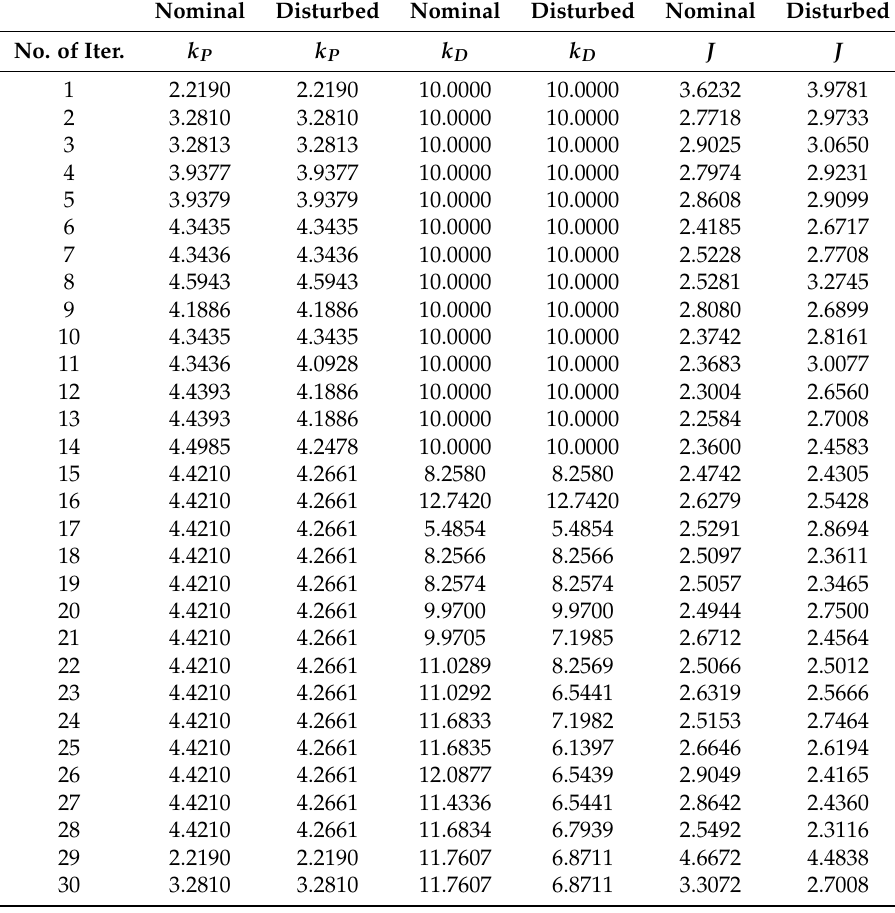
Table A1. Comparison of the results of auto-tuning of the UAV’s altitude controller using the GLD method—variants: nominal and at the presence of wind